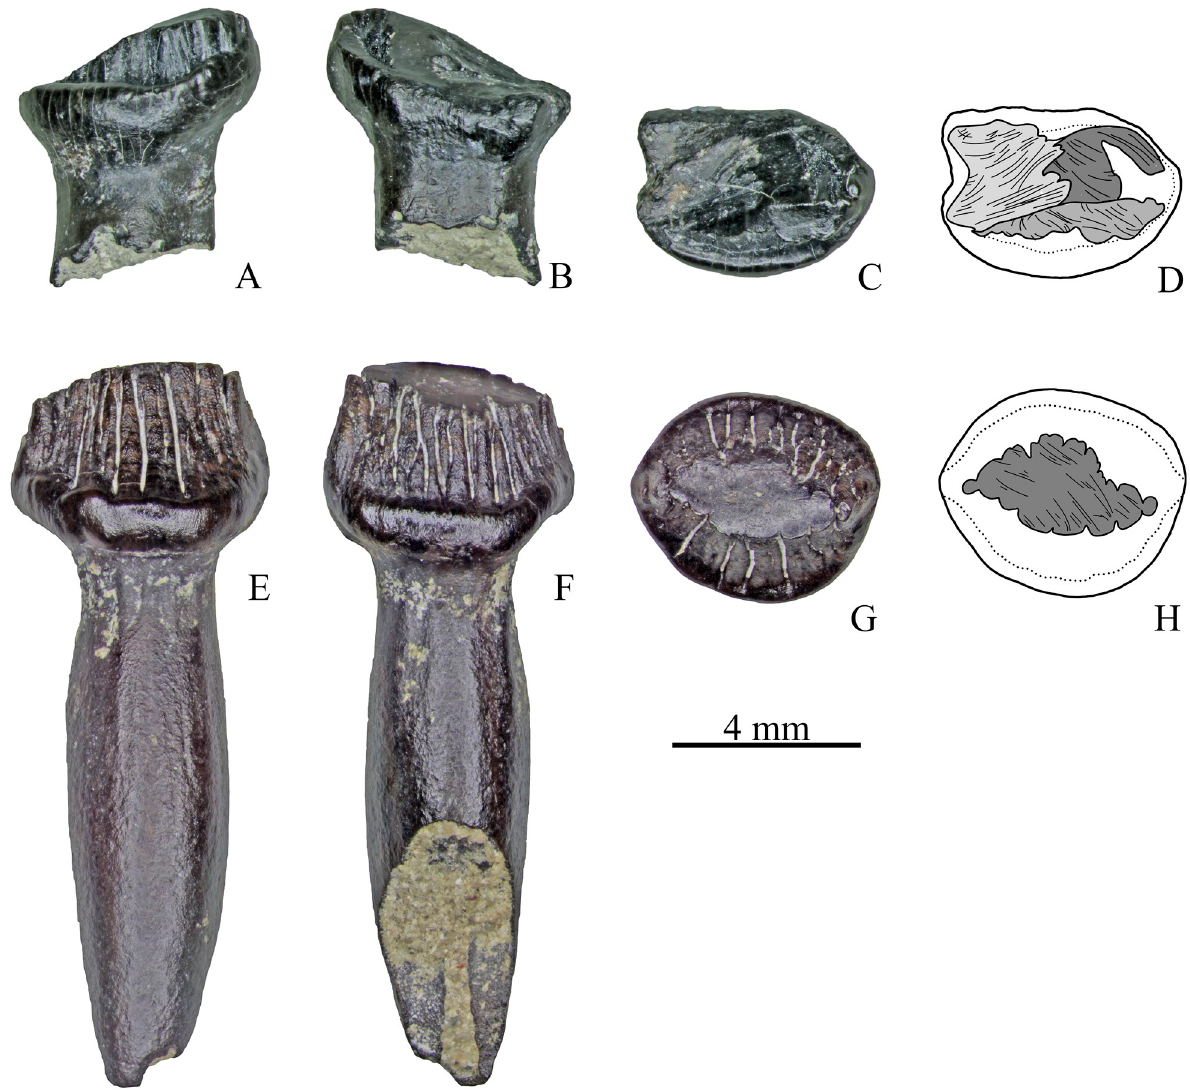
Fig 11. Teeth of Stegosauria indet. from the Teete locality Yakutia, Russia; Batylykh Formation (Lower Cretaceous) of unknown jaw positions. Specimens ZIN PH 14/246 (A-D), ZIN PH 71/246 (E-H) in labial or lingual (A-B; E, F), occlusal (C, G), and interpretive drawings in occlusal (D, H) views showing the wear facets with